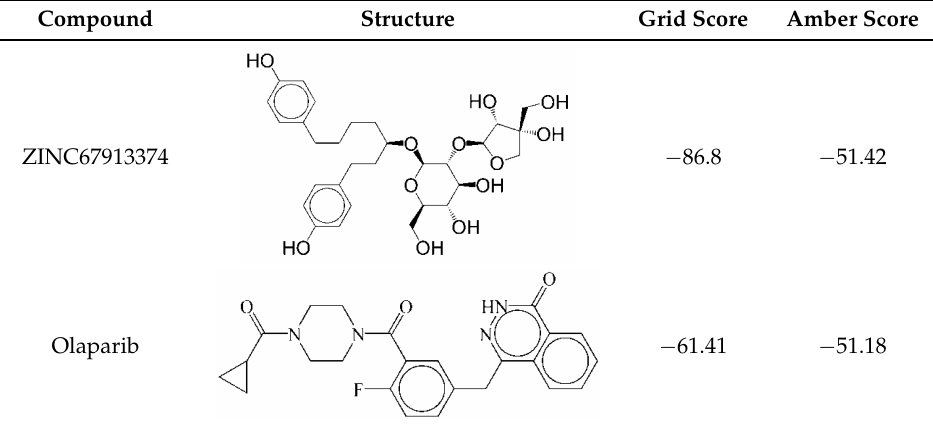
Table 1. Candidate PARP1 inhibitors from virtual screening.